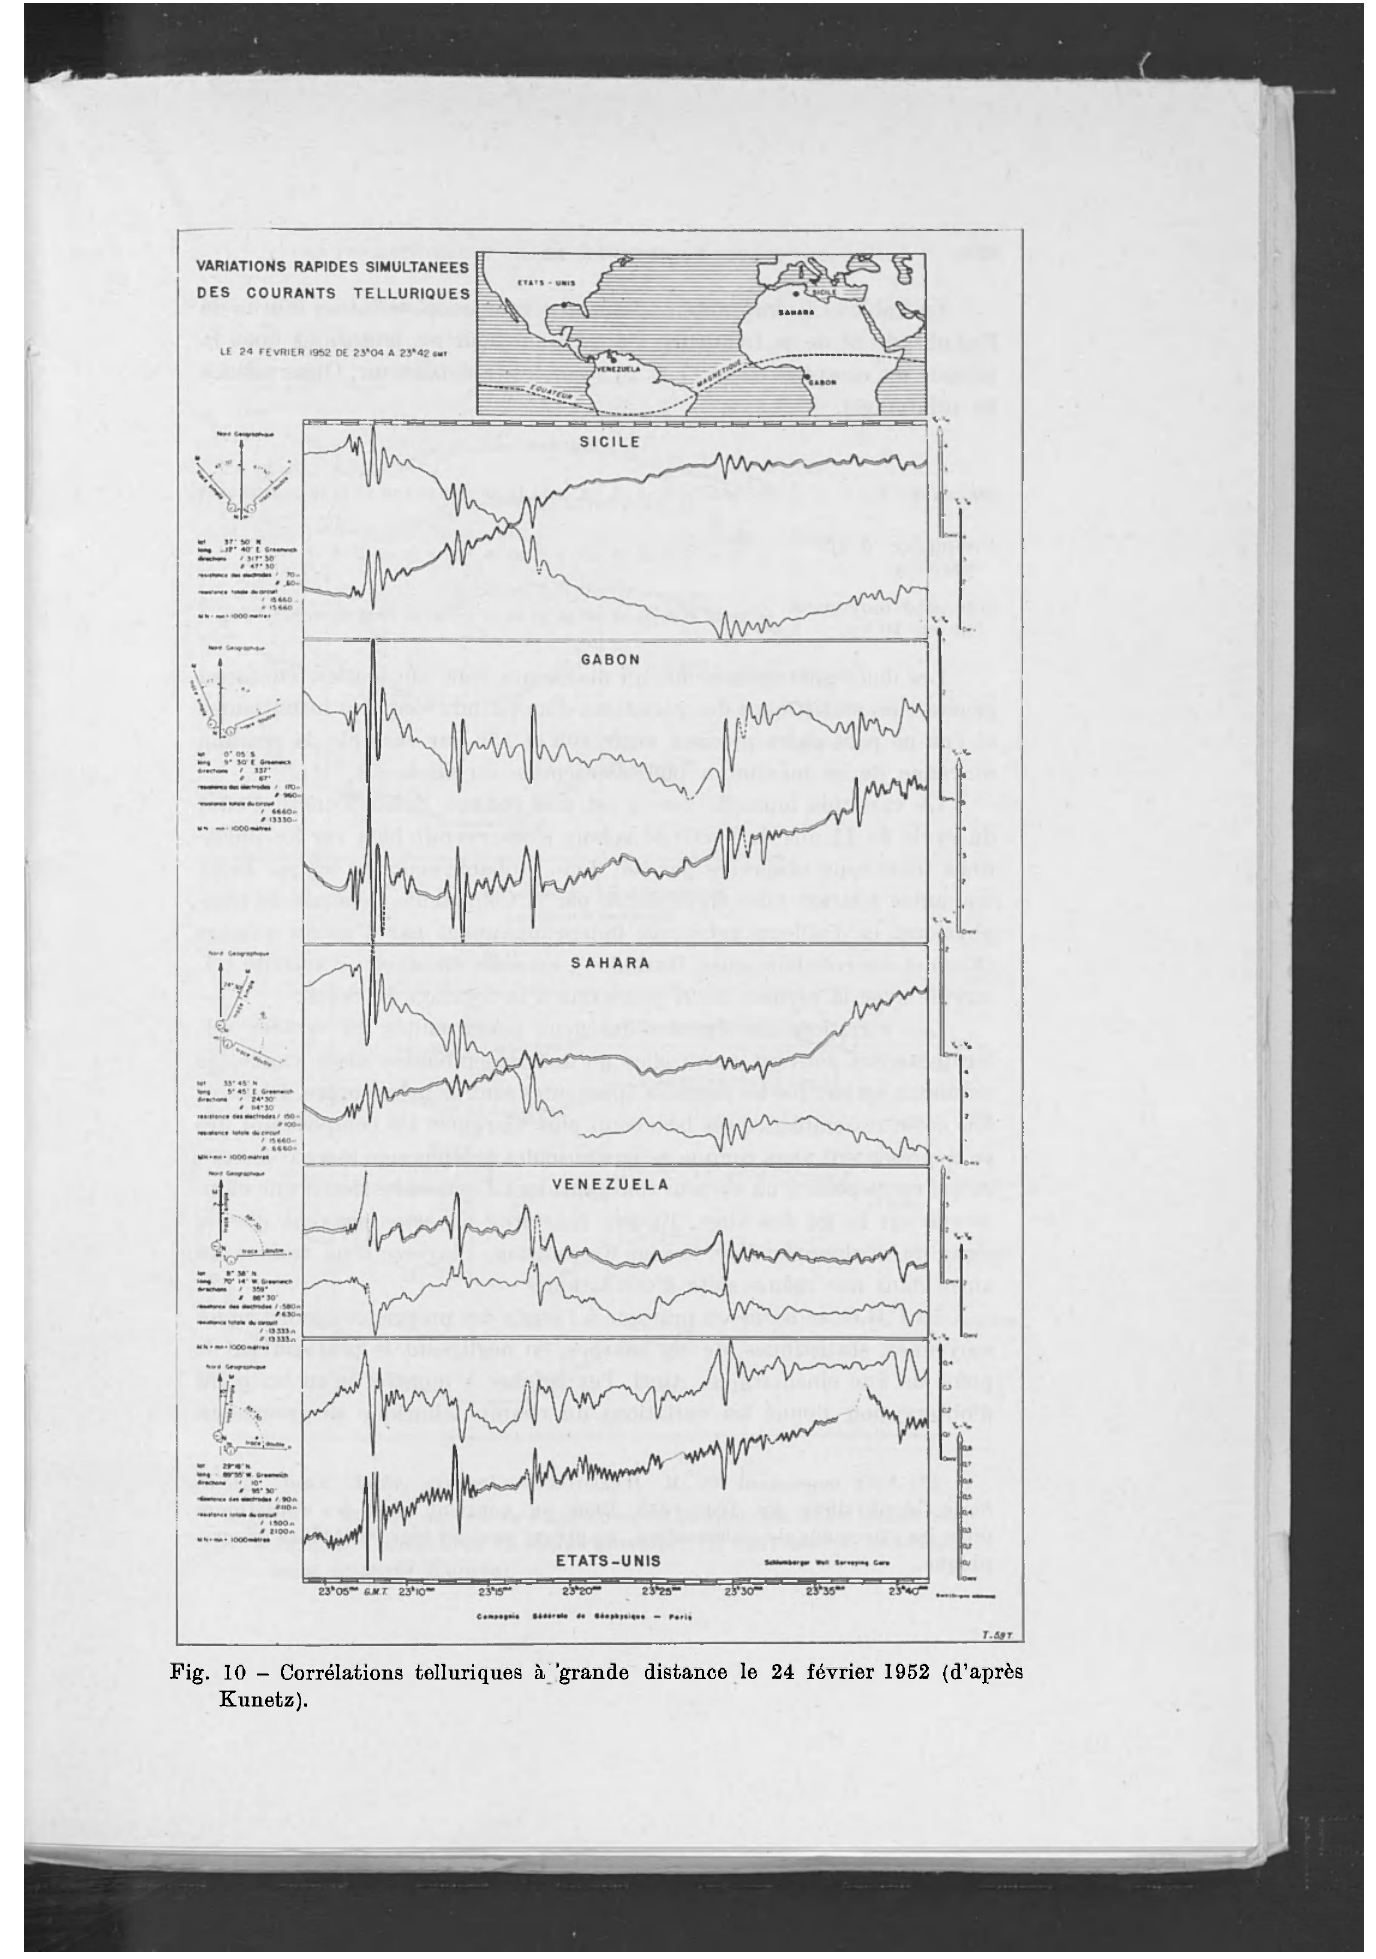
Fig. 10 - Corrélations telluriques à 'grande distance le 24 février 1952 (d'après